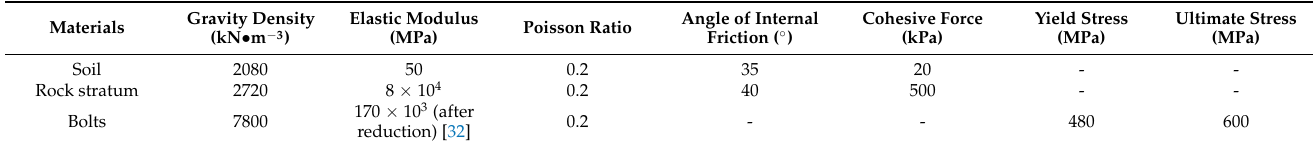
Table 1. Physical and mechanical